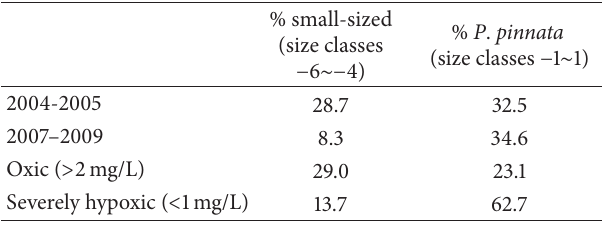
Table3:Similaritypercentage(SIMPER)contributionofpolychaete species in each group (top two sets). Species that contributed to the dissimilarities between the groups at the